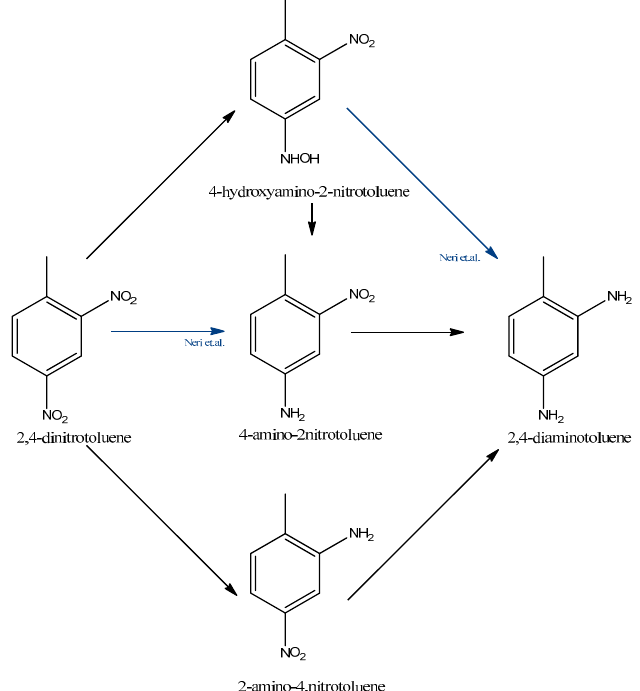
Figure 4. Dinitrotoluene hydrogenation pathways according to Janssen et al. and Neri et al. (Blue lines shows the new pathways comparable to Janssen et al.’s results.) [37] Electronic structure computational studies can be a great help in studying the reac- tion mechanism of three-phase catalytic hydrogenation reactions. In such a study, Barone et. al. applied the Monte Carlo algorithm to simulate the batch hydrogenation of 2,4-dini- trotoluene on a carbon-supported palladium catalyst [31,42,43]. They investigated the in- fluence of the molecular adsorption modes, the steric hindrance, and the metal dispersion on the reaction mechanism. They found that the steric hindrance of the different surface species had the largest influence on the mechanism. Hajdu et al. worked on a new catalyst that contains precious metal on chromium- oxide nanowires for 2,4-toluenediamine synthesis [44]. In our previous work, we exam- ined and described a possible reaction mechanism based on the GC-MS results. Our study confirms the mechanism by Neri et.al., as we detected the presence of nitroso and hydrox- ylamine compounds (Figure 5).